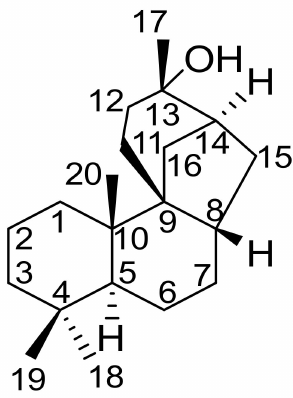
Figure 1. Stemodane diterpenes C-atom skeleton and C(13)